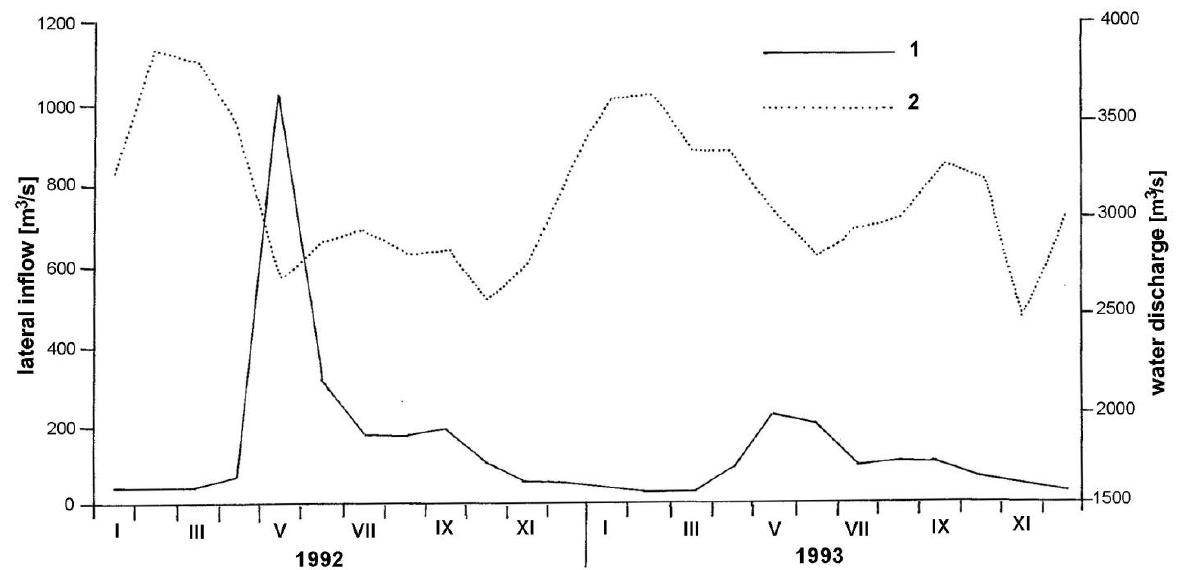
Fig. 5. Integrated plots of the monthly average of lateral inflow (1) in the Ust-Ilim reservoir against the water discharge of the Ust-Ilim power plant (2) in contrasting years (after Tashlykova, 2010, changed)